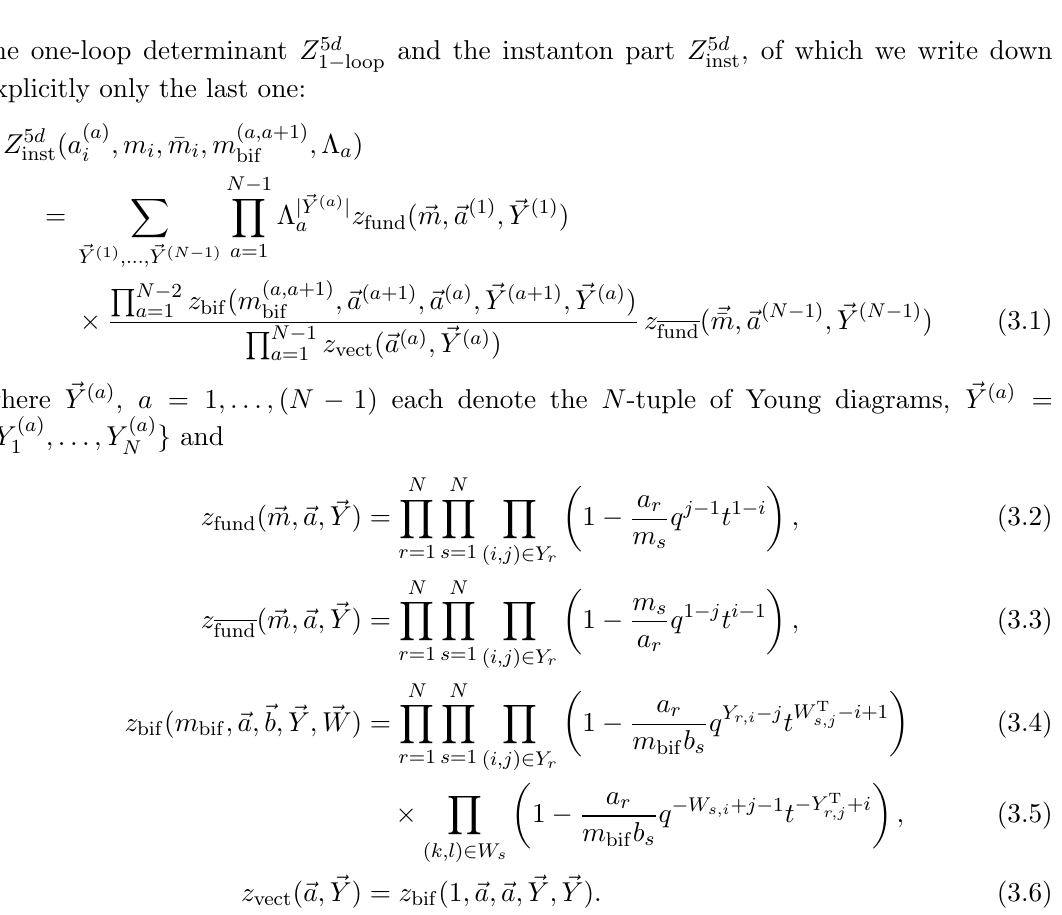
Figure 5 . 5 d linear \square" quiver gauge theory with gauge group U(4) 3 . a ( a ) tiated vevs of the adjoint scalars. m ( a;a +1) gauge